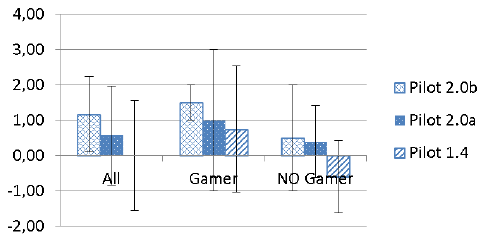
Figure 11. Spatial perception